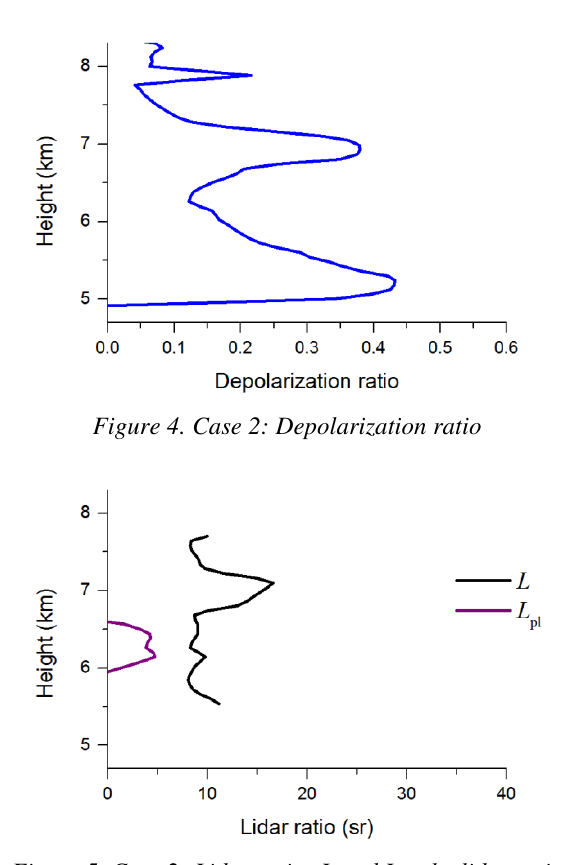
Figure 1 . Case 1: Four simultaneously measured profiles of Eqs.(2), (3), (5), and (6). Profiles are scaled Figure 3. Case 2: Perpendicular and parallel backscattering coefficients measured simultaneously